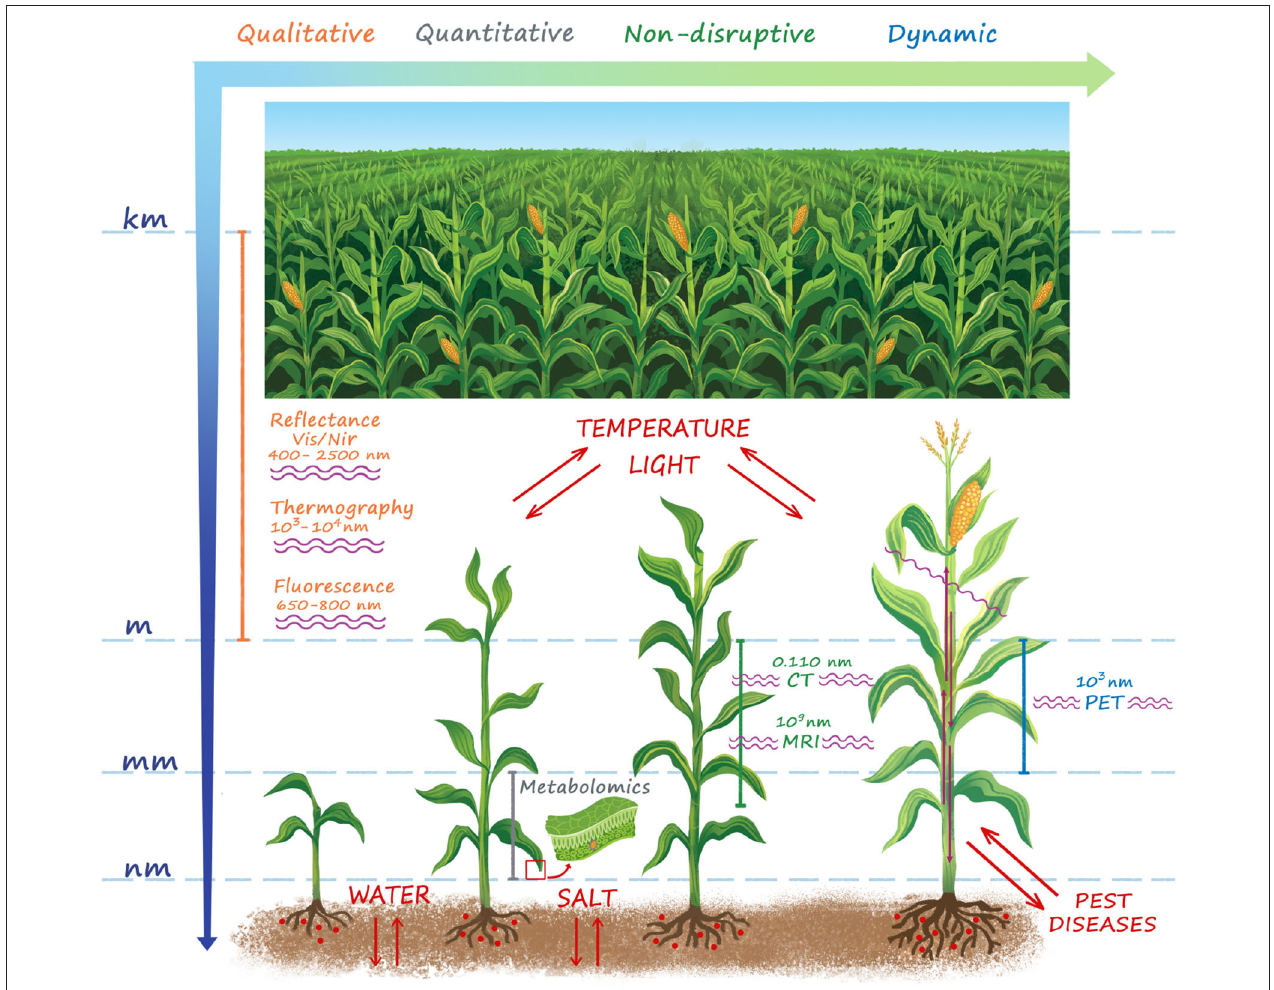
FIGURE 1 | A summary of the main techniques for plant stress detection. The stressors and the wavelength used for stress detection in each technique are also shown. Stress manifests itself over a wide length scale ranging from the microscopic cellular to the macroscopic plant and field level. Whole field sensing (VIS/NIR reflectance, Thermography, Fluorescence) is naturally attractive in the agricultural practice, but provides only a qualitative information. At plant level morphological imaging techniques (CT, MRI) provide quantitative high resolution detection of structural damages induced by the stress, but cannot provide any information on the functional basis of the physiological mechanisms of reactions to both biotic and abiotic stressors at cellular level. For this purpose, metabolomics is an essential tool to enhance the results obtained with morphologic imaging techniques, but it is sample disruptive and is not able to provide timely indications to support early interventions both in open-field and controlled conditions. PET is by far the only quantitative functional imaging technique, which provides a time-dynamic non-disruptive information of the modifications of functional mechanisms and transport flows in the vascular system in response to biotic and abiotic stress.